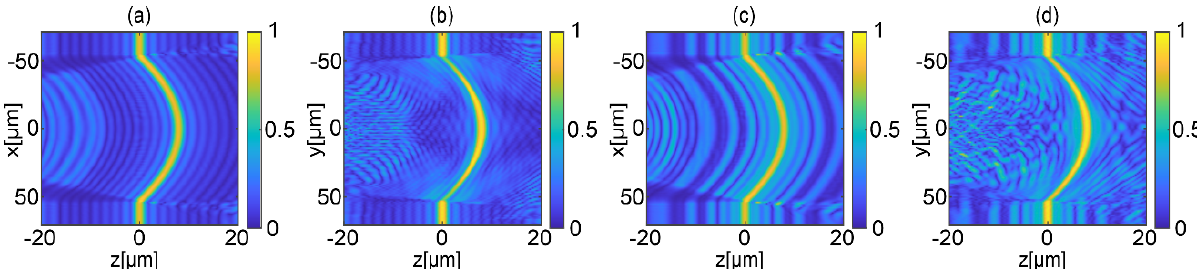
Figure 4. Numerical LSFs for a 3D micro focusing object when using different illumination scanning strategies: ( a ) horizontal and ( b ) vertical cross-section for equally angle spaced strategy, respectively; ( c ) horizontal and ( d ) vertical cross-section for geometrically frequency spaced strategy.